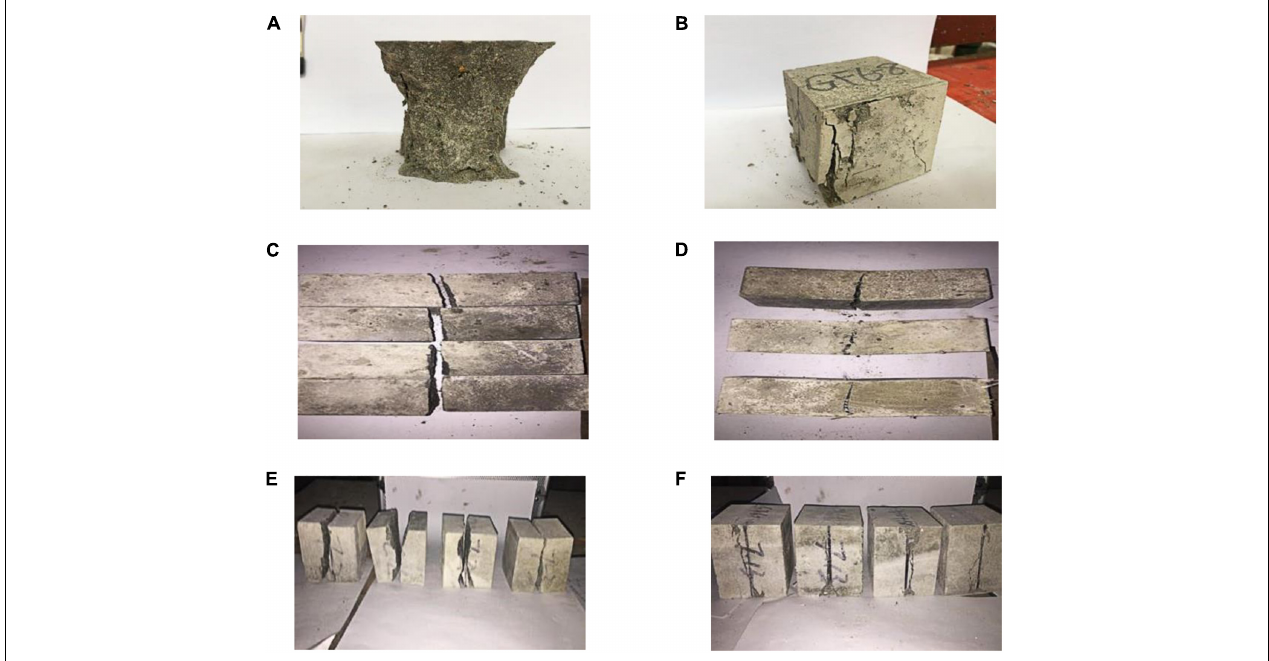
FIGURE 1 | Typical failure modes of fine-grained concrete specimens. (A) Compression failure without fibers, (B) compression failure with fibers, (C) bending failure without fibers, (D) bending failure with fibers, (E) splitting tensile failure without fibers, and (F) splitting tensile failure with fibers.